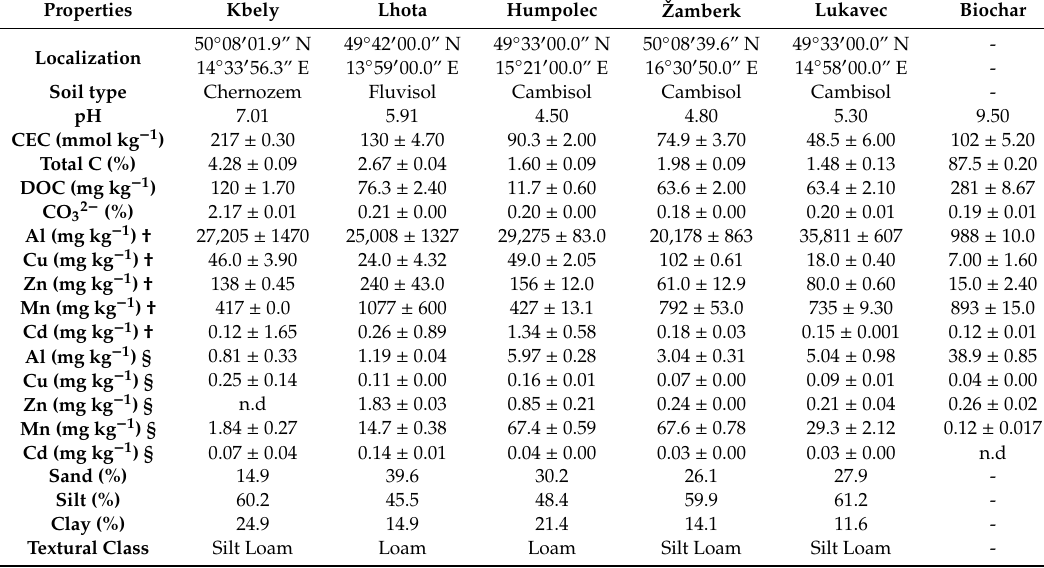
Table 1. Selected physiochemical properties of incubated soils and